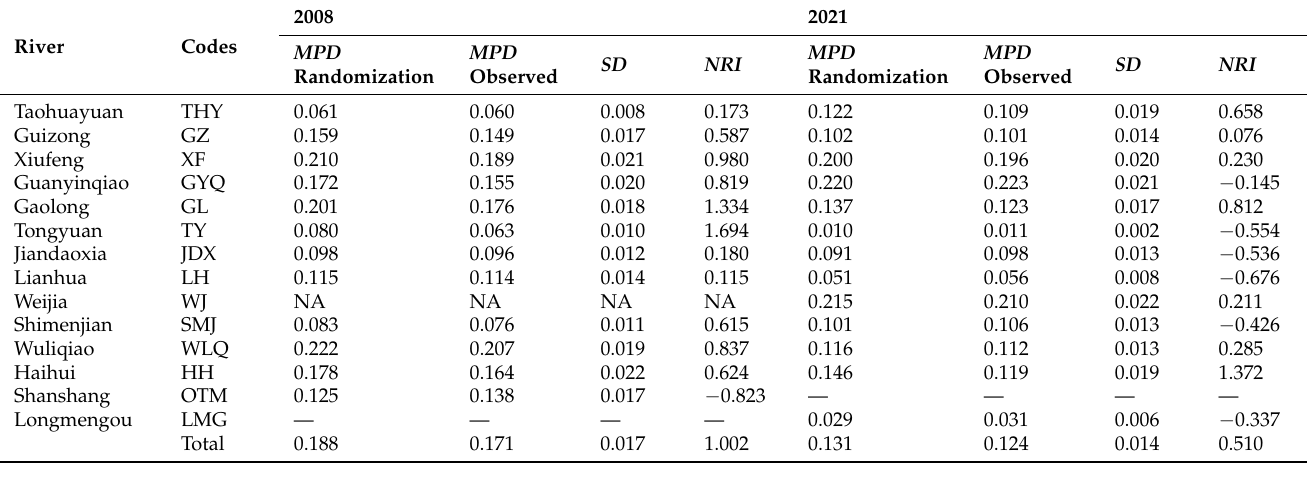
Table 1. The phylogenetic distance ( MPD ) randomization and observed, standard deviation of random values ( SD ) and net relatedness index ( NRI ) of fish in the Lushan National Nature Reserve in 2008 and 2021.